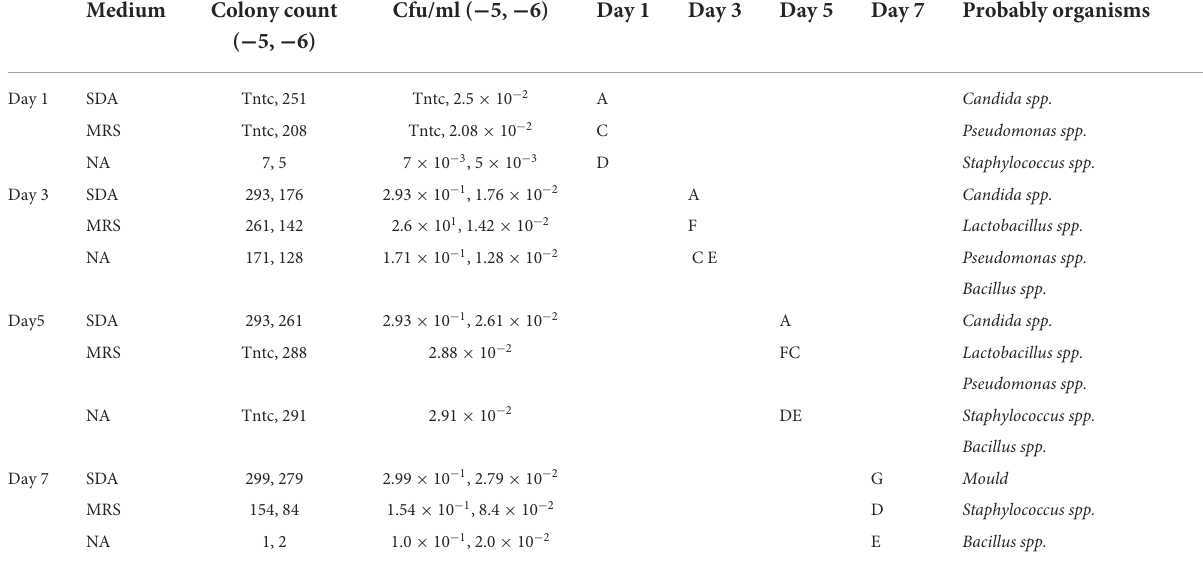
TABLE 1a Succession of microorganisms during cocoa bean fermentation. Medium